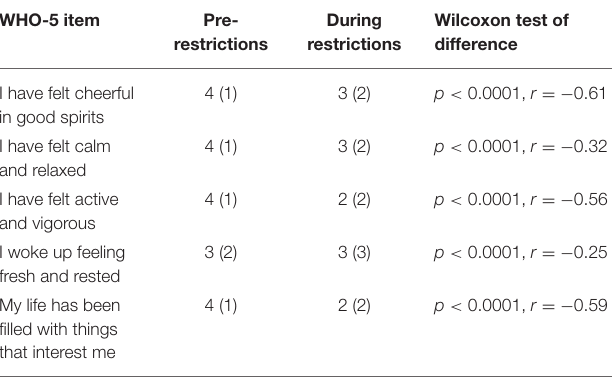
TABLE 2 | Subdimensions of the WHO-5 index before and during public life restrictions (median and interquartile range). WHO-5 item Pre- During restrictions